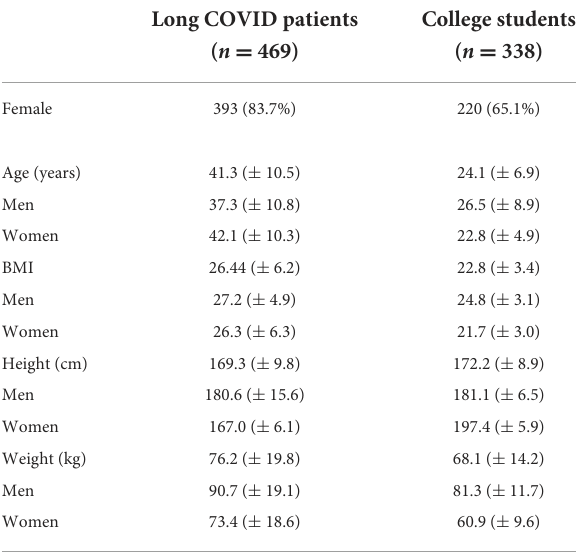
TABLE 1 Baseline characteristics of the long COVID group and control